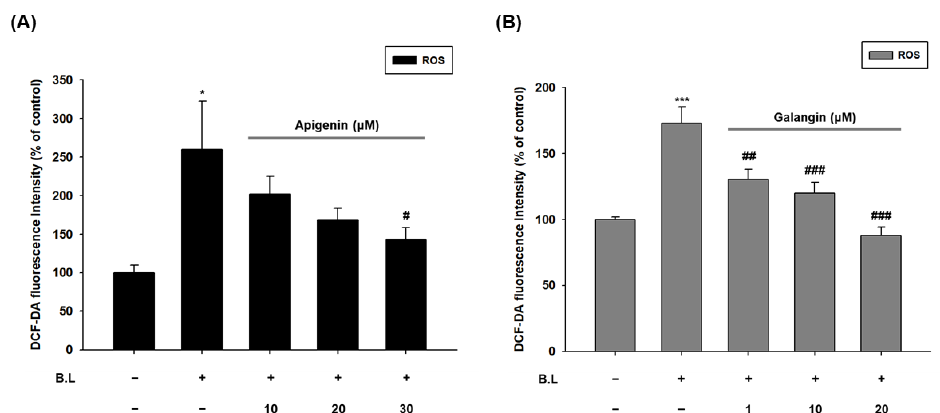
Figure 4. Apigenin and galangin decreased oxidative stress induced by blue light irradiation. ( A , B ) ROS production was determined by DCF-DA assay. Cells were incubated with apigenin (10, 20, 30 μM) ( A ) or galangin (1, 10, 20 μM) ( B ) for 24 h and were then irradiated with blue light (30 min, 76 W/m 2 ). After 24 h incubation, the cells were subjected to the same process twice and were finally subjected to DCF-DA assay. * p < 0.05 vs. control, *** p < 0.005, # p < 0.05 vs. B.L, ## p < 0.01%, ### p < 0.005%.